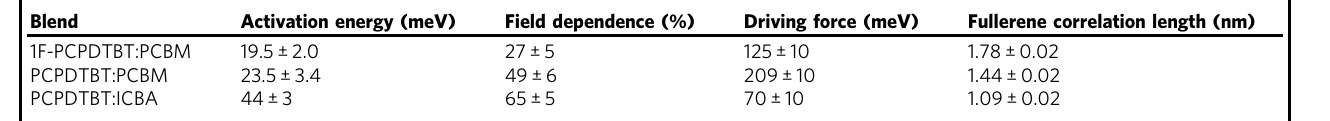
Activation energies of free charge formation taken from Figs. 3f and 4c, d Bias dependence of charge generation at 200K and below bandgap excitation, expressed as the percentage decrease of collected charge when increasing the pre-bias from − 2 to 0.4V Driving force for electron transfer, which is the energy difference between the relaxed singlet exciton on the donor and of the CT state Correlation length of the fullerene clusters from